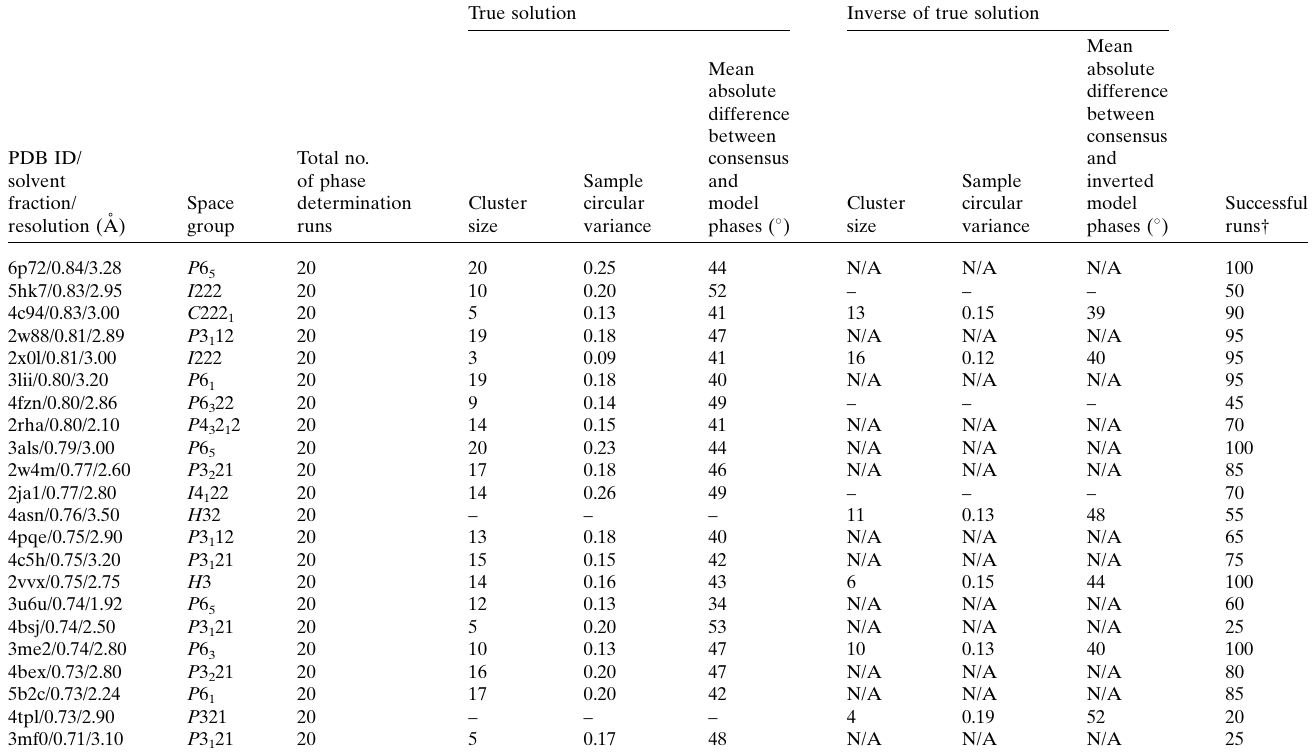
Table 1 Results of phase set clustering for the 22 successful test